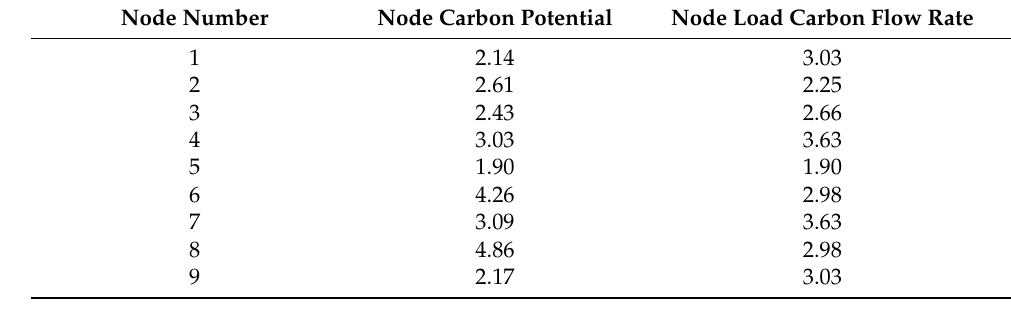
Table 5. Carbon emission flow indicators.